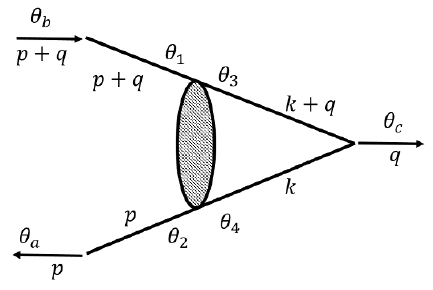
Figure 6. Diagrams contributing to corresponds to the general Φ 4-point function discussed in section 4.2.1.